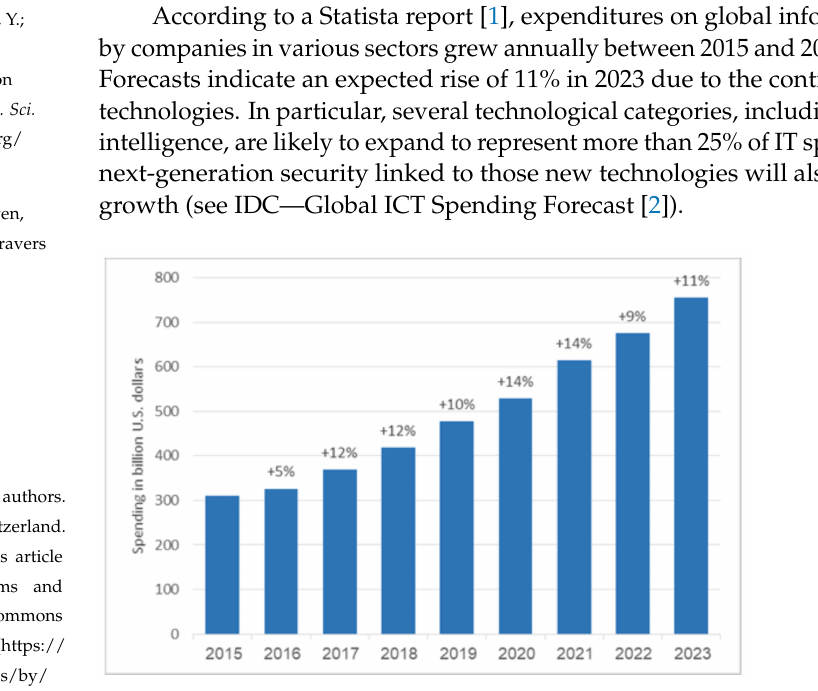
Figure 1. International IT spending for 2015 through